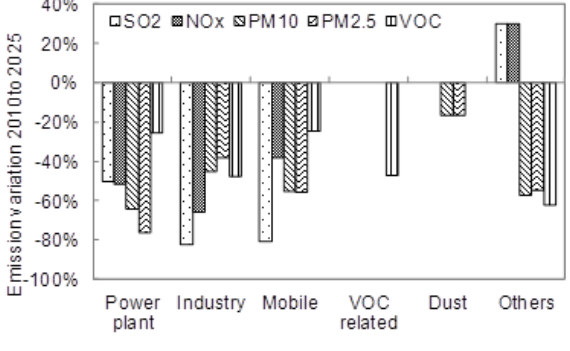
Fig. 8. Sector based emission reduction percentage in PRD by 2025. 2 Fig. 8. Sector-based emission reduction percentage in PRD by 2025.